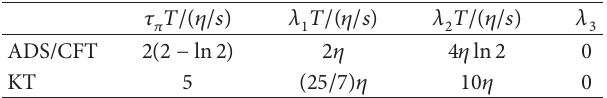
Table 1: Comparison of transport